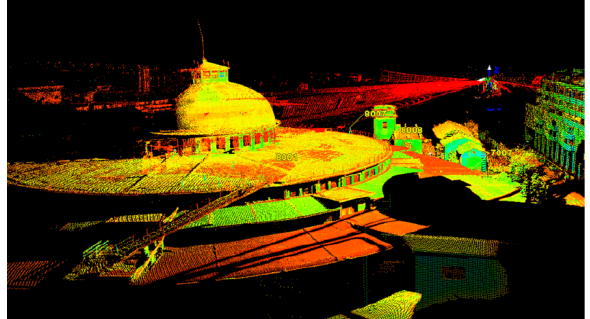
Figura 3. View of a single point cloud acquired from an aerial mobile platform at about 40 m from the ground.